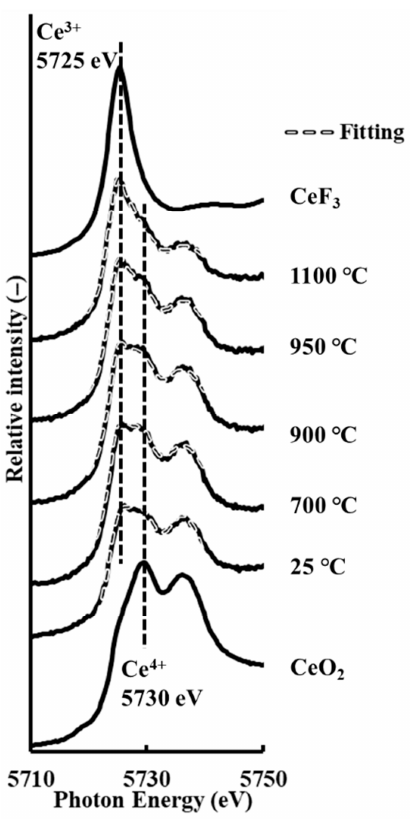
Figure 2. Cerium L III edge X-ray absorption fine structure spectra, corresponding to X-ray absorption near-edge structure analysis of the region, both without and with grinding, showing the resolved components of tri- and tetravalent cerium based on cerium fluoride(CeF 3 ) and tetravalent cerium oxide(CeO 2 ) as reference spectra,